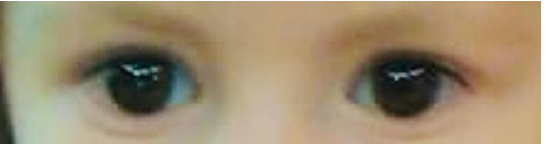
Figure 1. Clinical feature of the subject with OI/EDS overlap syndrome: Proband’s photographs showing blue sclerae.